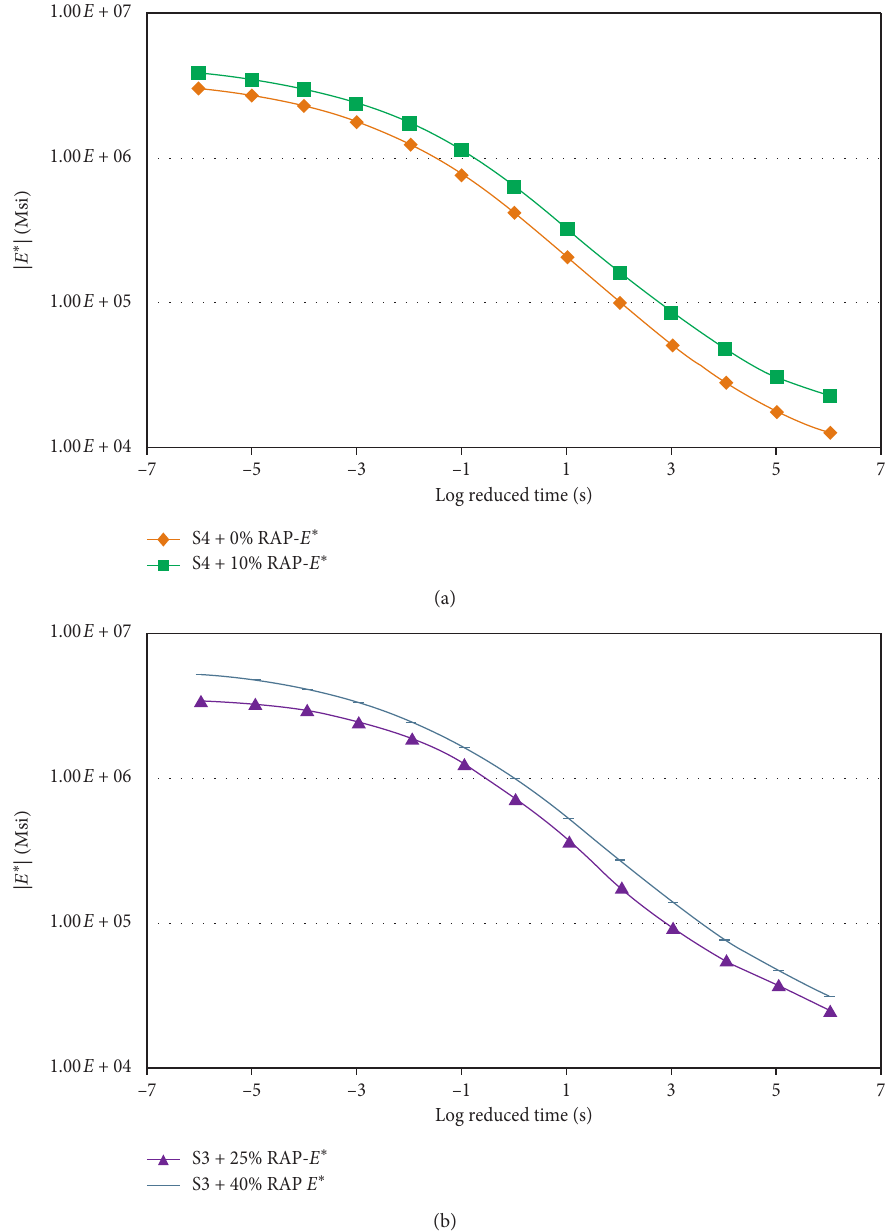
Figure 4: Comparison of E ∗ master curves: (a) S4 mixes and (b) S3